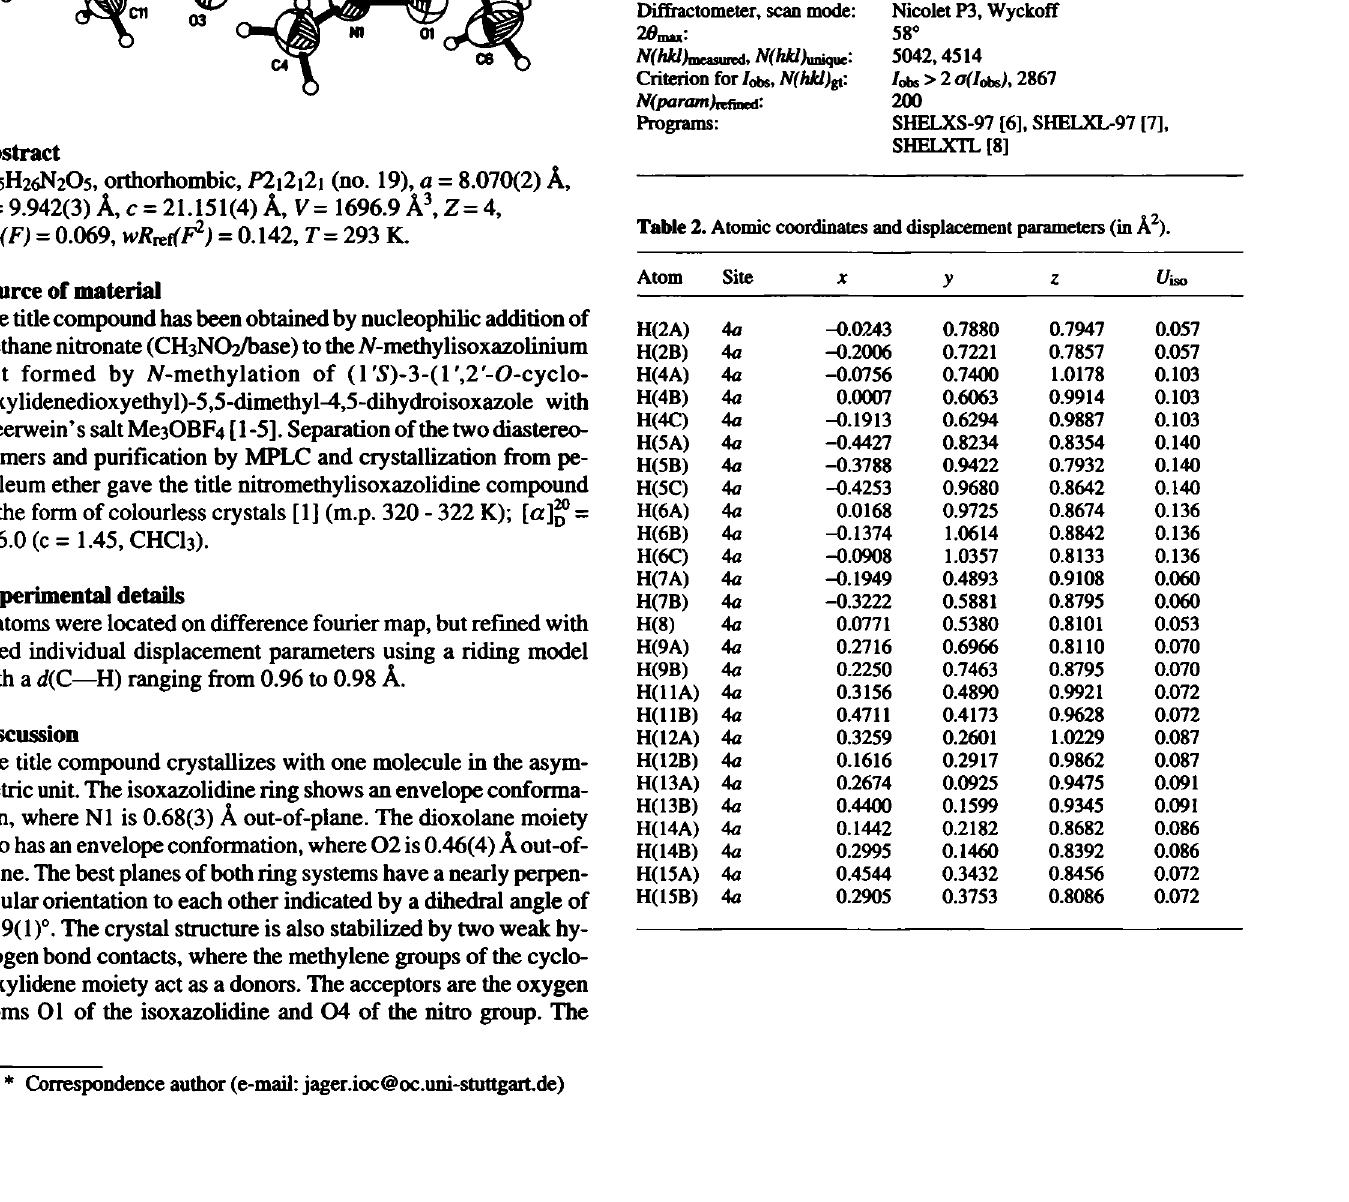
Table 1. Data collection and handling.